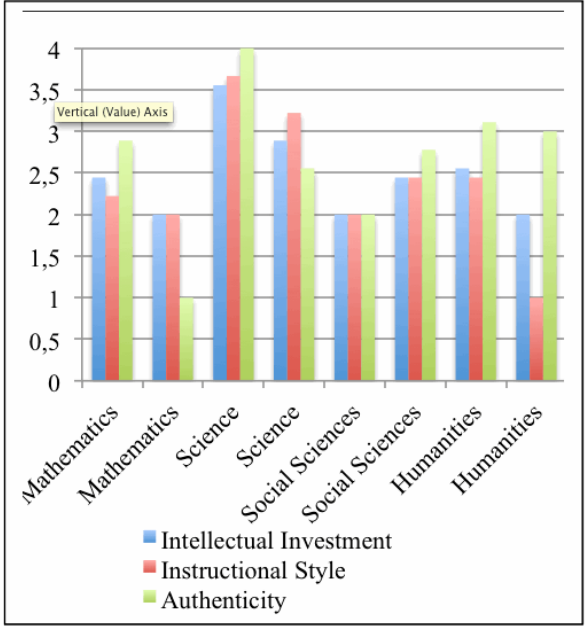
Figure 2. Class observation data collected to different teacher for Grate Ten students. Documents related to the thermos project and